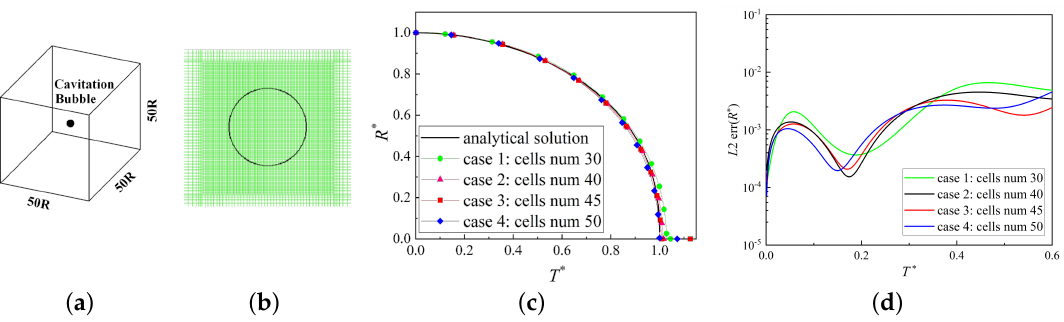
Figure 2. ( a ) Illustration of computational domain; ( b ) 2D illustration of the local domain containing a bubble with grid refinement; ( c ) comparisons of the temporal evolution of bubble radius between analytical solution and numerical results with different cells in the bubble; ( d ) evolution of L 2 error of bubble radius versus